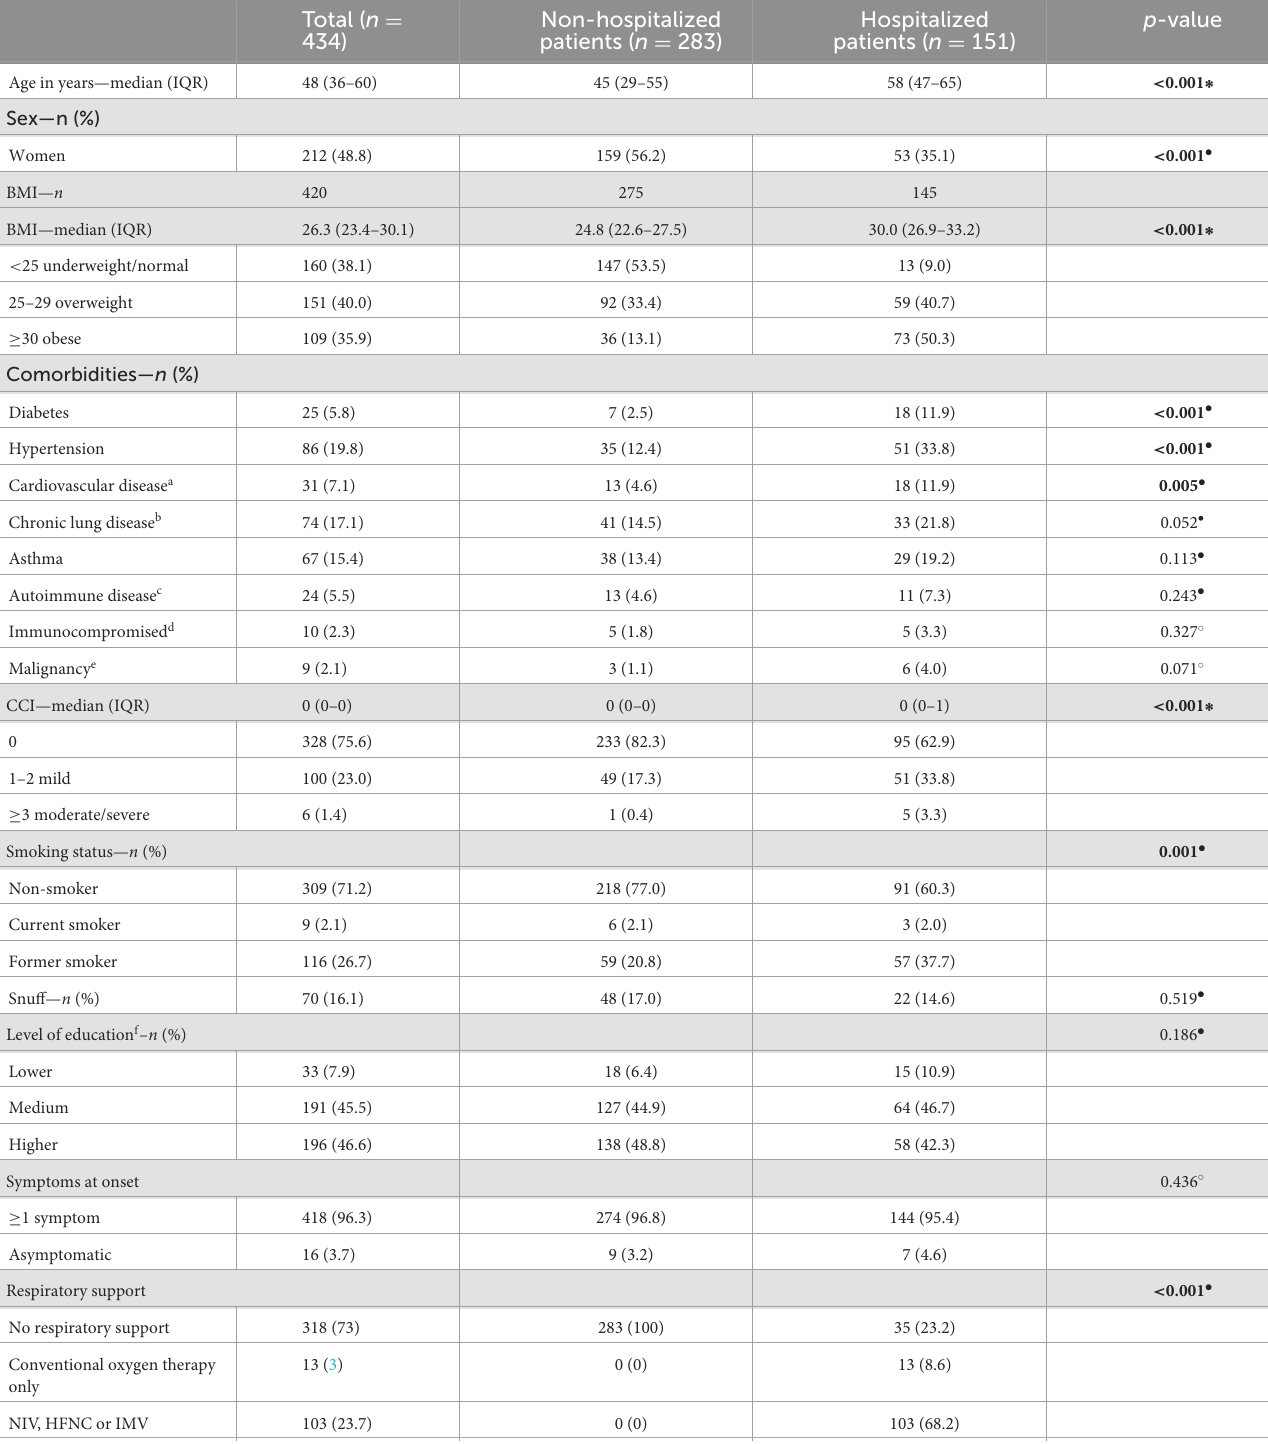
TABLE 1 Demographic and baseline characteristics of all hospitalized and non-hospitalized patients that attended the 6-month follow-up visit.